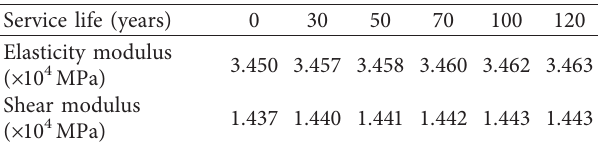
Table 2: Elastic modulus and shear modulus of C50 in different service